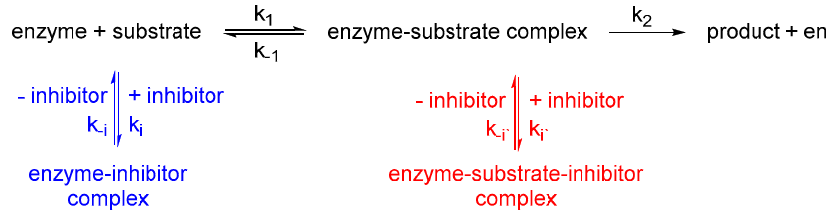
Scheme 10: Competitive, blue, uncompetitive, red, and mixed, blue and red, inhibition in enzyme